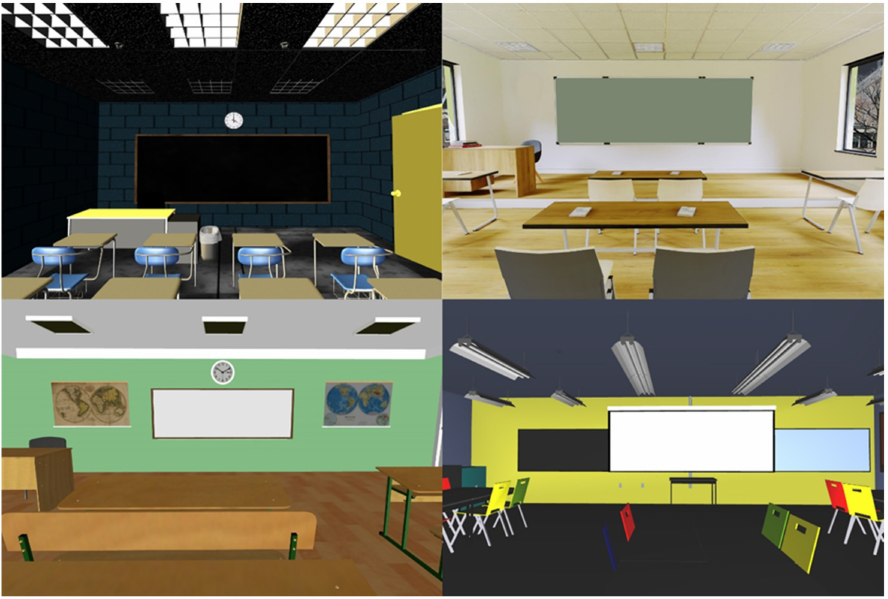
Figure 1. Four physical VR